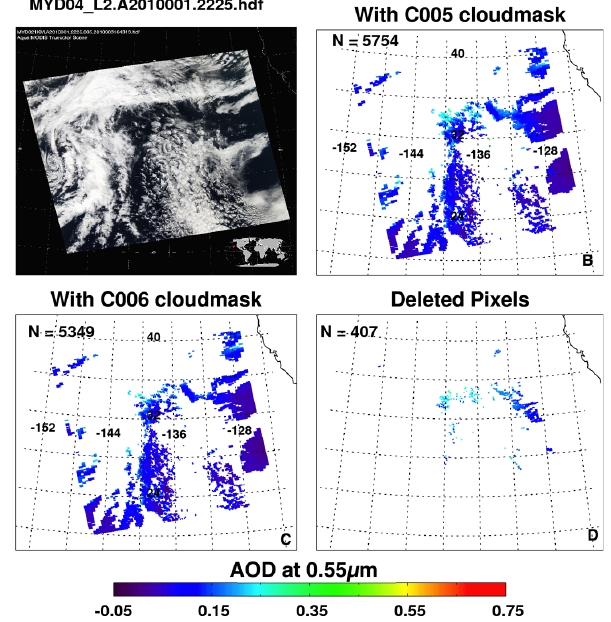
Fig. 13. Granule retrieved over the Pacific Ocean from MODIS- Aqua taken on 1 January 2010 at 22:25UTC. Top left: true- color (RGB) showing scene taken from modis-atmos.gsfc.nasa.gov. (b and c) Retrieved high quality (QAC ≥ 1 over ocean) AOD at 0.55µm, without/with the revised 1.38µm cloud mask test. (d) Cir- rus contaminated pixels that have been removed over